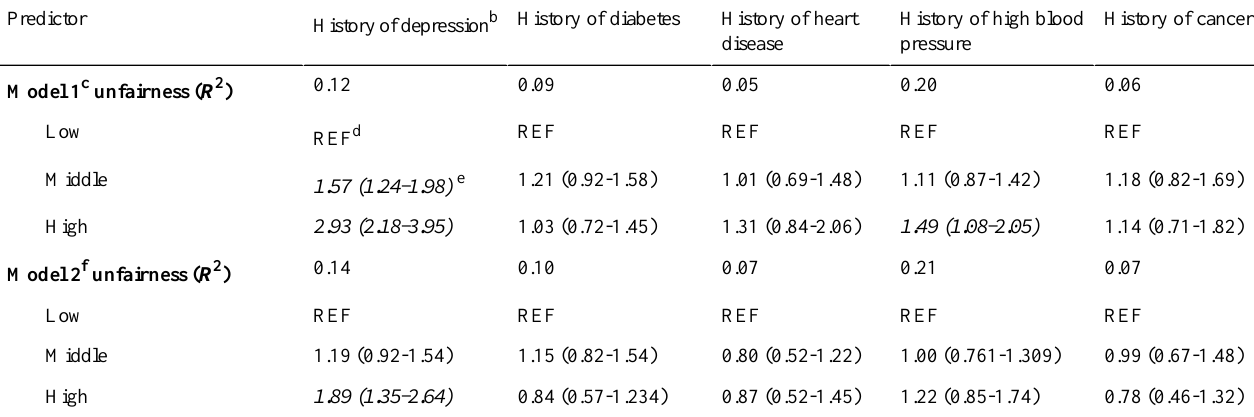
Table 4. Adjusted odds of self-reported history of illness by unfairness and discrimination a